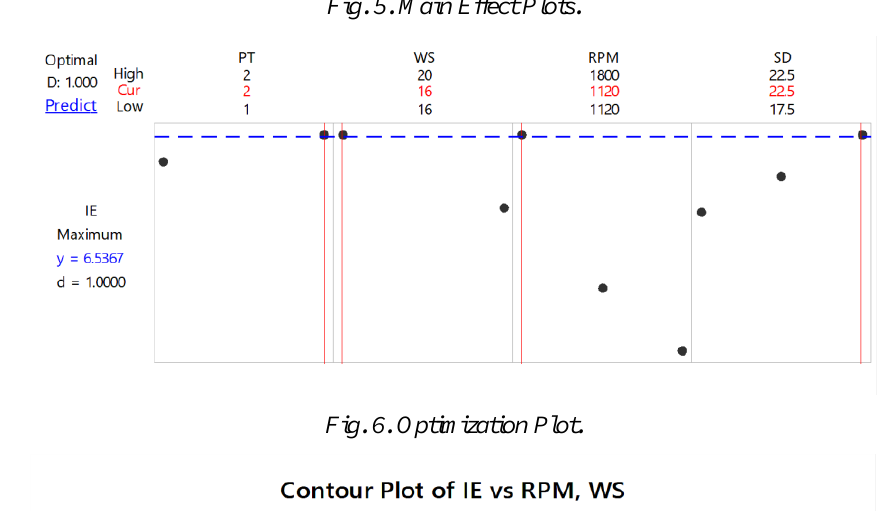
Fig. 5. Main Effect Plots.